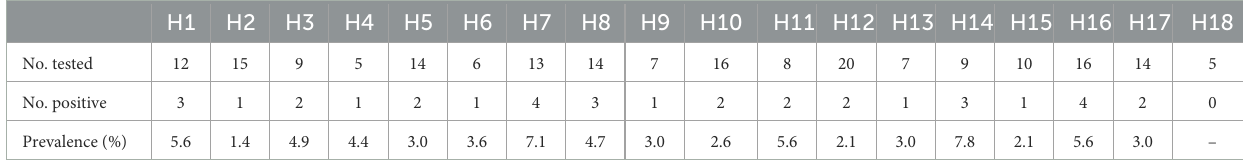
TABLE 2 Prevalence of BovHepV detected in ticks collected from different cattle herds in